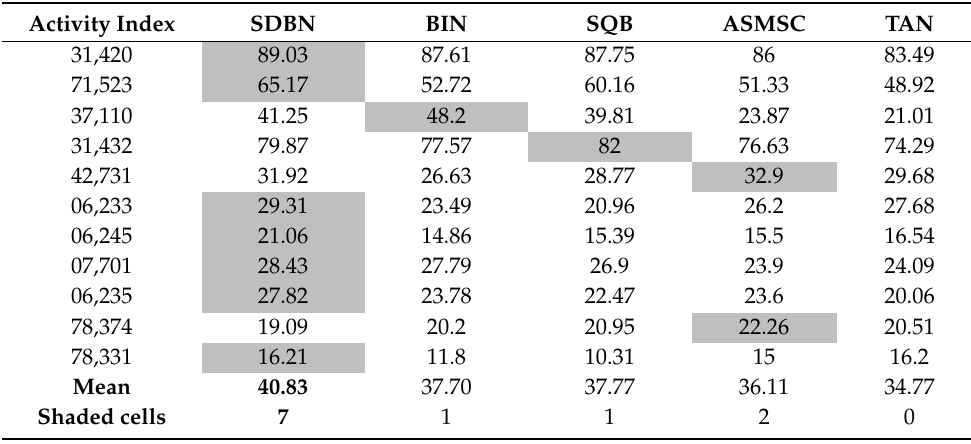
Table 5. Retrieval results of top 5% for MDDR-DS1 dataset.